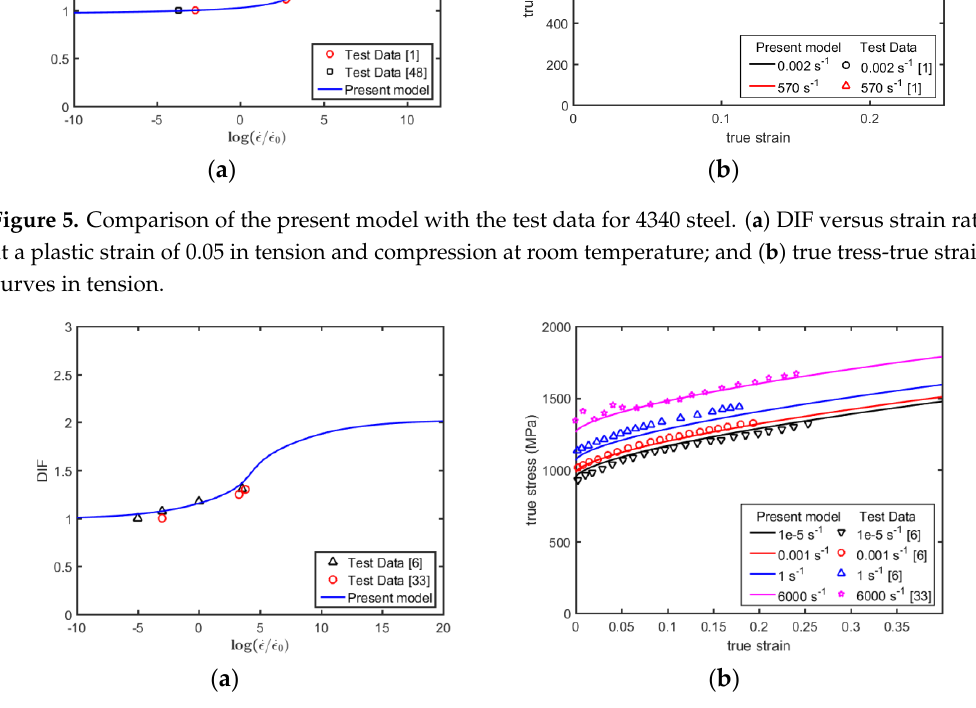
Figure 6. Comparison of the present model with the test data for Ti-6Al-4V alloys. ( a ) DIF versus strain rate at a plastic strain of 0.05 in compression at room temperature; and ( b ) true tress-true strain curves in compression.